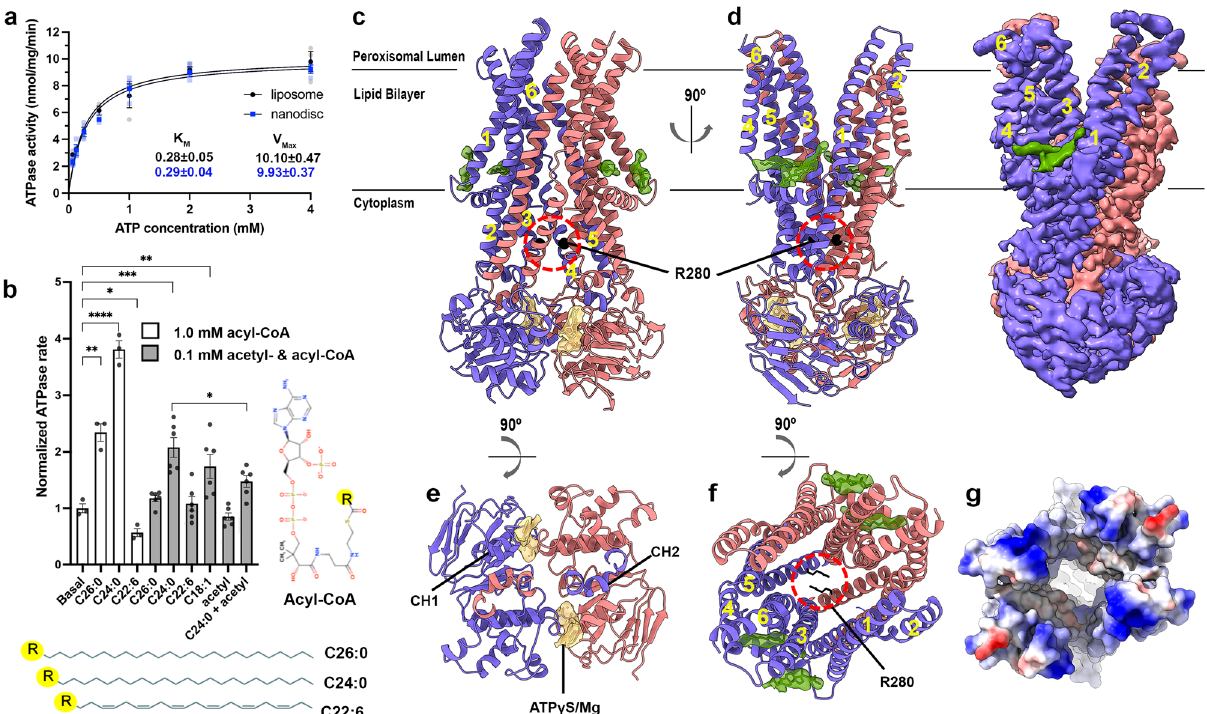
Fig. 1 Structural and Functional characterization of outward open human ABCD1. a ATPase activity of ABCD1 reconstituted in liposomes or nanodiscs as a function of ATP concentration, n = 3 and error bars represent standard deviation b ATPase activity of DDM/CHS detergent puri fi ed ABCD1 in the presence of CoA esters of the indicated varying acyl chain composition, normalized to ABCD1 ’ s basal rate at left, n = 6 (100 µ M) or 3 (1mM) and error bars represent S.E.M. Statistical signi fi cance by unpaired, two-tailed t-test p -values of <0.05, 0.01, 0.001, 0.0001 are indicated by *, **, ***, ****, respectively. c − f Map and structure of human ABCD1 outward open (OO) homodimer viewed from the membrane plane, made using only OO particles. EM density (0.04 contour) and ribbons are colored red and slate for each ABCD1 monomer, black sphere for R280, and green and yellow for modeled lipid-like entities and bound nucleotides, respectively. e Peroxisomal lumen with TMDs removed for clarity and f peroxisomal lumen with intracellular gate circled (dashed red line) with NBDs removed for clarity. TMs are numbered g electrostatic surface representation of ABCD1 viewed as a slice from the peroxisomal